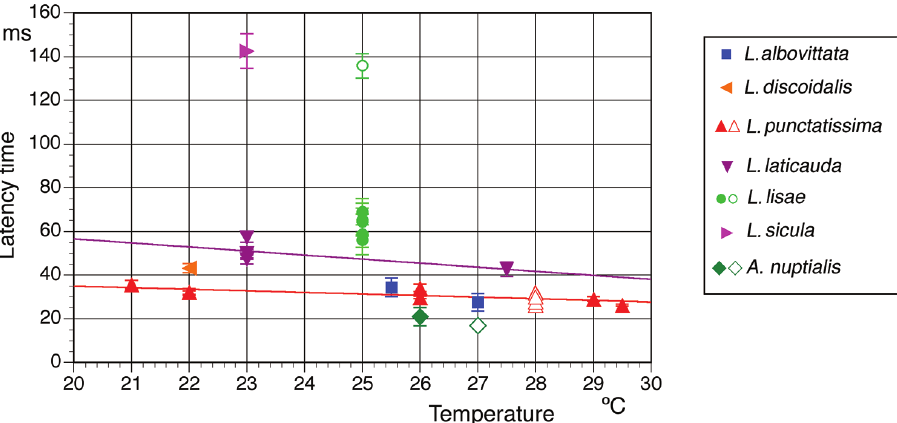
Figure 1. Latency times of the female response. The times refer to the beginning of the male song with temperature in European Leptophyes species and Andreiniimon nuptialis. Open symbols: L. punctatissima from Robinson et al. 1986; L. lisae , see text; A. nuptialis from Heller and Helversen 1986. Error bars indicate SD, regression lines based on own data (for details, see